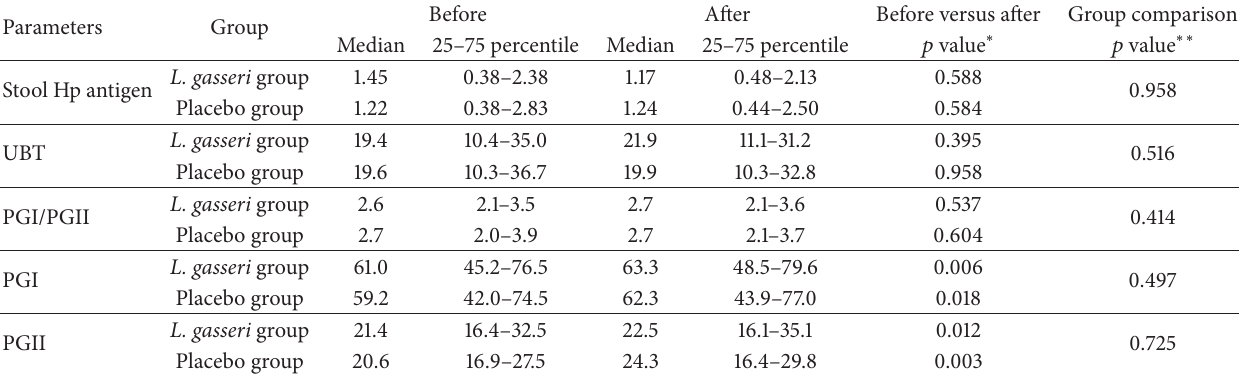
Table 2: Effects of Lactobacillus gasseri consumption on Helicobacter pylori infection and serum pepsinogen levels. Parameters